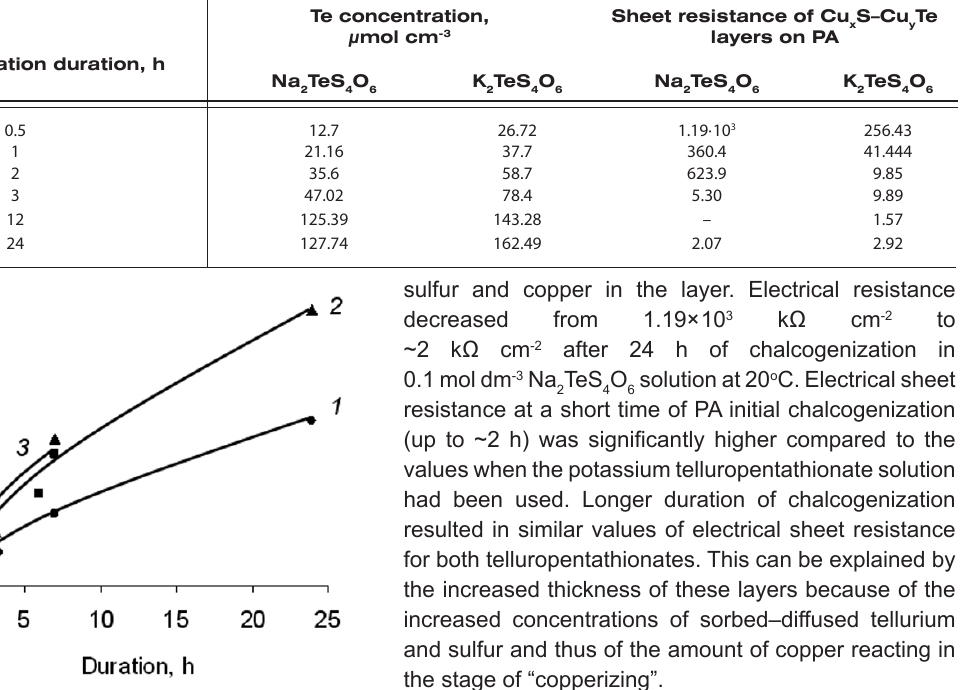
Figure 15. Dependence of copper concentration in PA on